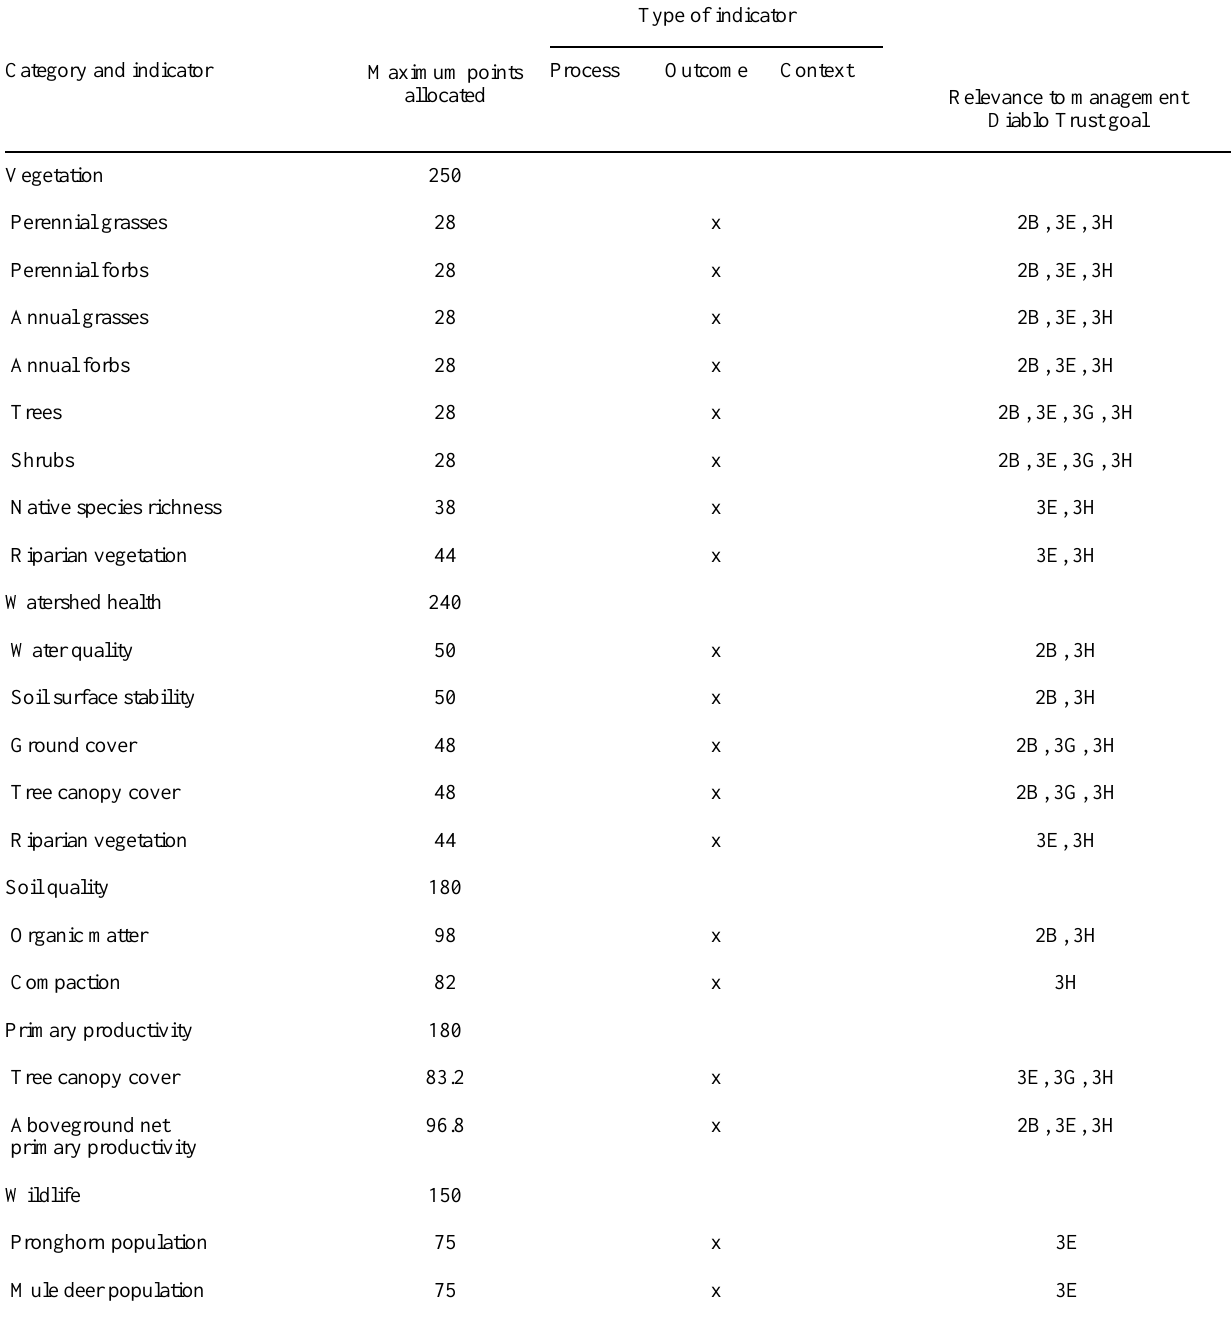
Table 4. Ecological branch indicators selected through the participatory approach to develop the holistic ecosystem health indicator for the Diablo Trust collaborative organization. The maximum points allocated are the estimated weighted points assigned to each category and nineteen indicators out of the total 1000 points. Each indicator may provide information related to the process, outcome, or context of the collaborative organization. The relevance of the indicators to the management goals was classified according to the Diablo Trust three-part holistic goal (Table